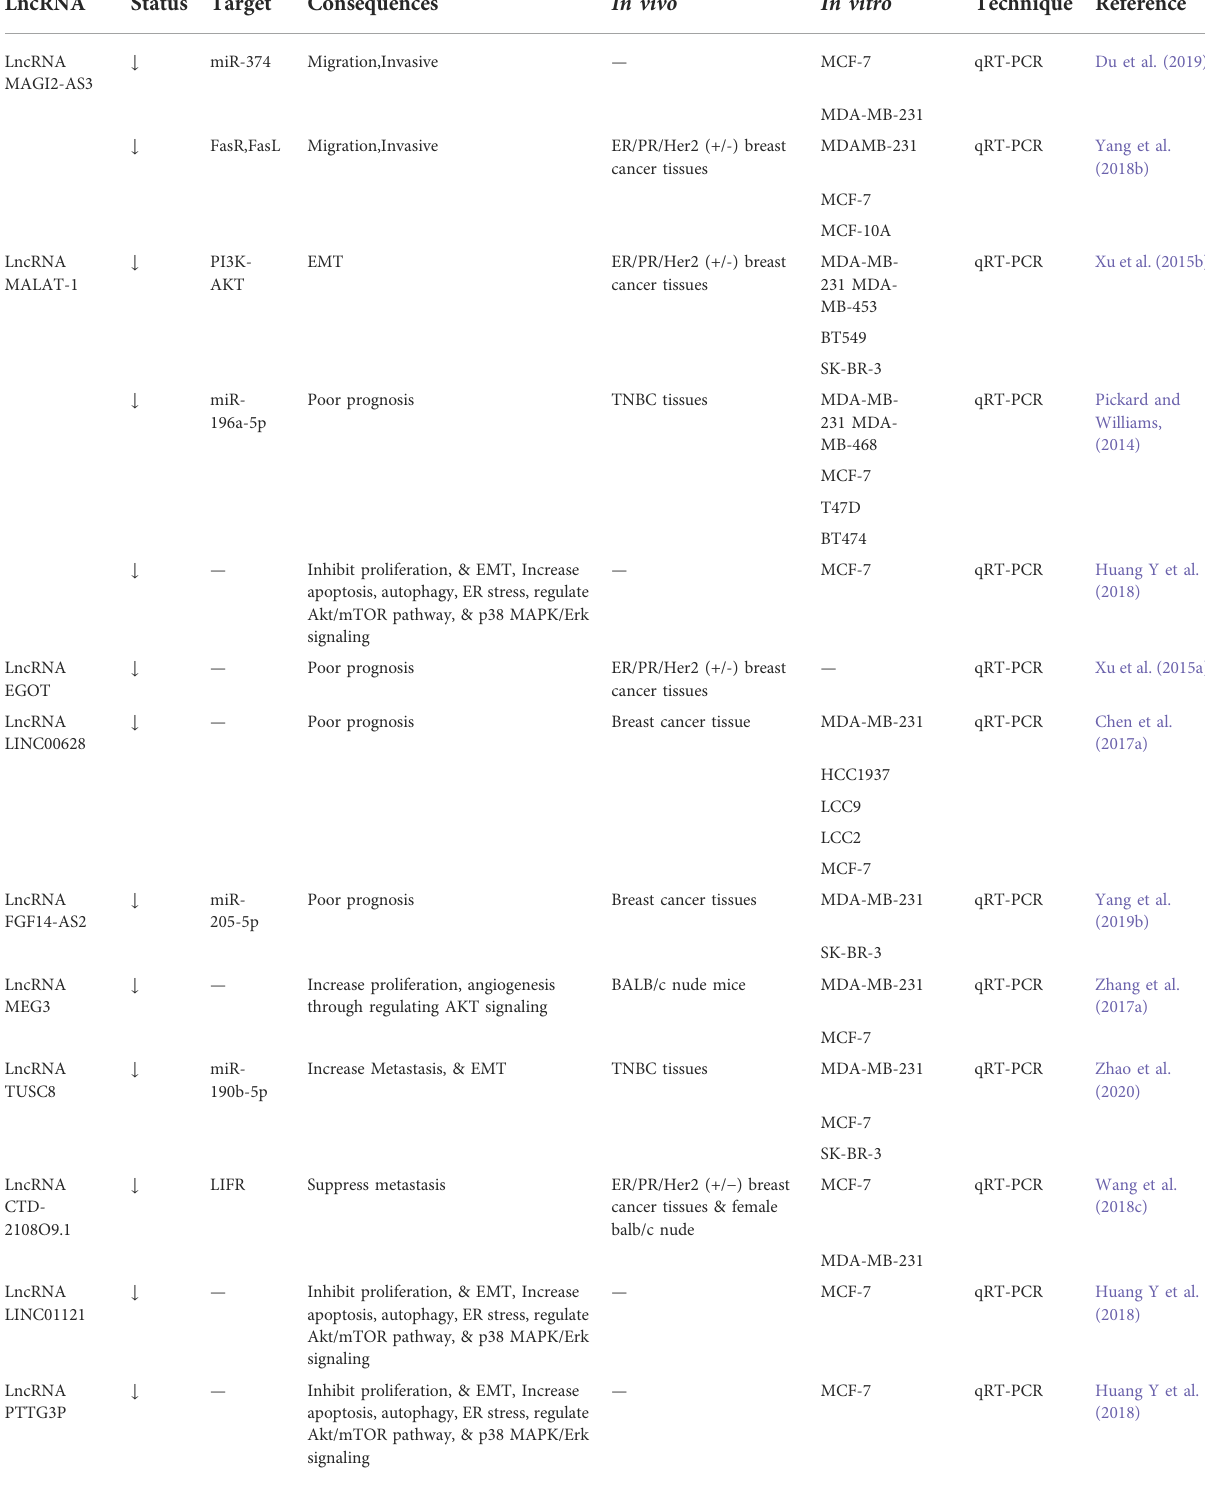
TABLE 3 Summaryof functions, targets, and experimentalmodels used for studying the downregulated longnoncodingRNAs in different invivo and in vitro investigations.